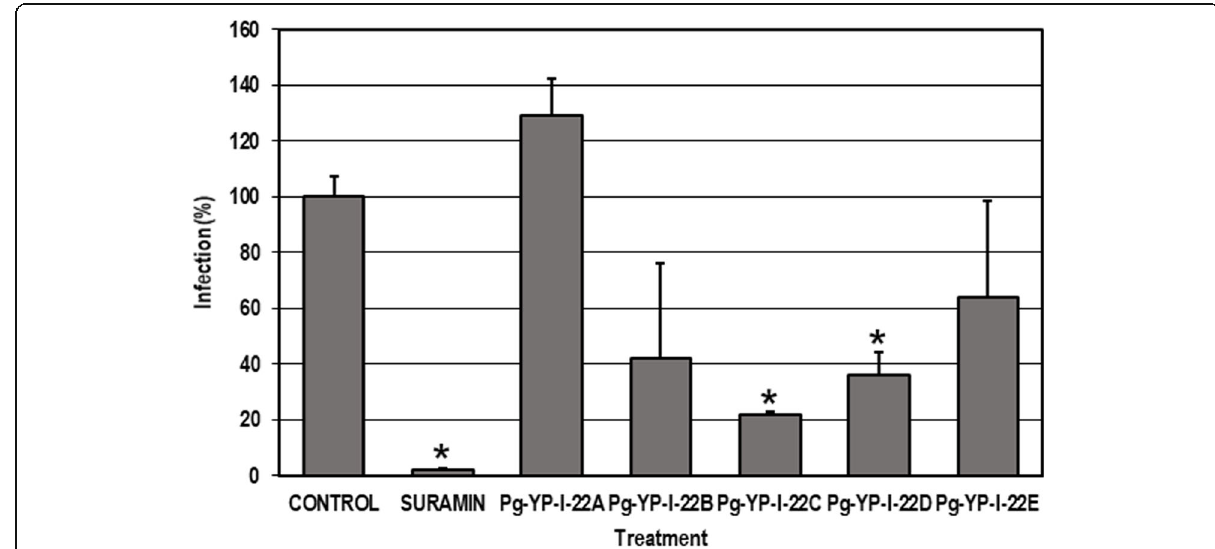
Fig. 2 Inhibition of infectious particle production by the P. guajava fraction. Cultures were infected (MOI = 1) and then treated for 48 h with each of the five fractions (100 μ g/mL). The error bars correspond to the SEM. The asterisks indicate cases with statistically significant differences (Student ’ s t-test; p < 0.05) in relation to the control without treatment. N = 4